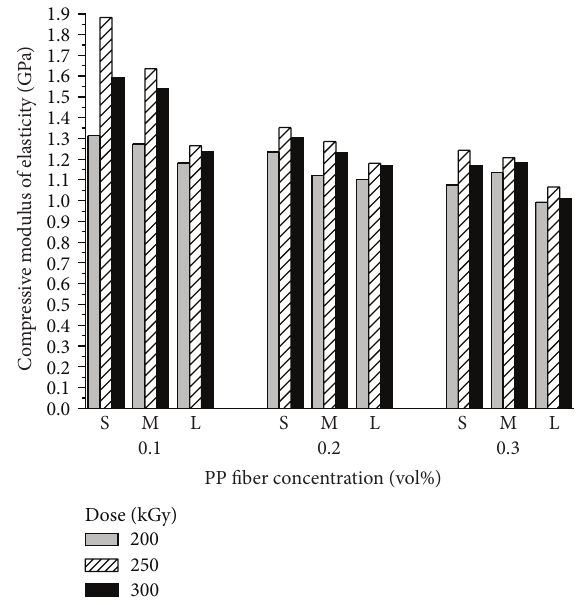
Figure 6: Compressive modulus of elasticity of irradiated-polymer concrete with different marble particle sizes and fiber concentra- tions.